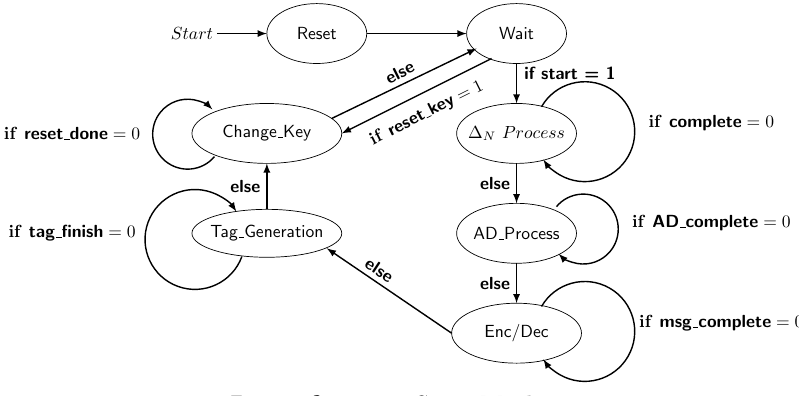
Figure 6: Finite State